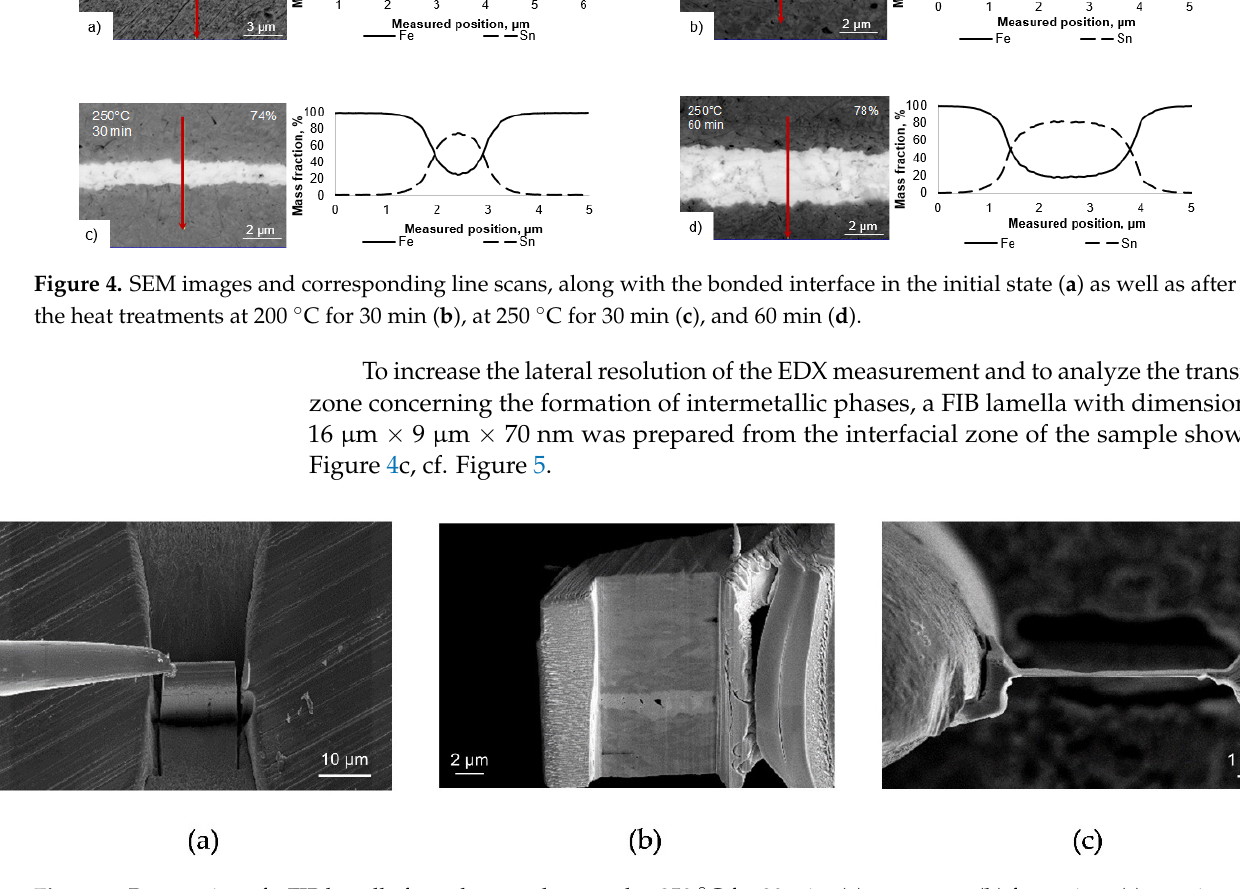
Figure 5. Preparation of a FIB lamella from the sample treated at 250 °C for 30 min: ( a ) coarse cut, ( b ) front view, ( c ) top view.